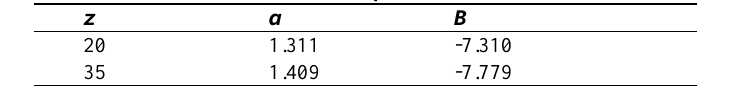
Table 7. The calculated value of Forchheimer a and b constant coefficients for the levels of 20 and 35